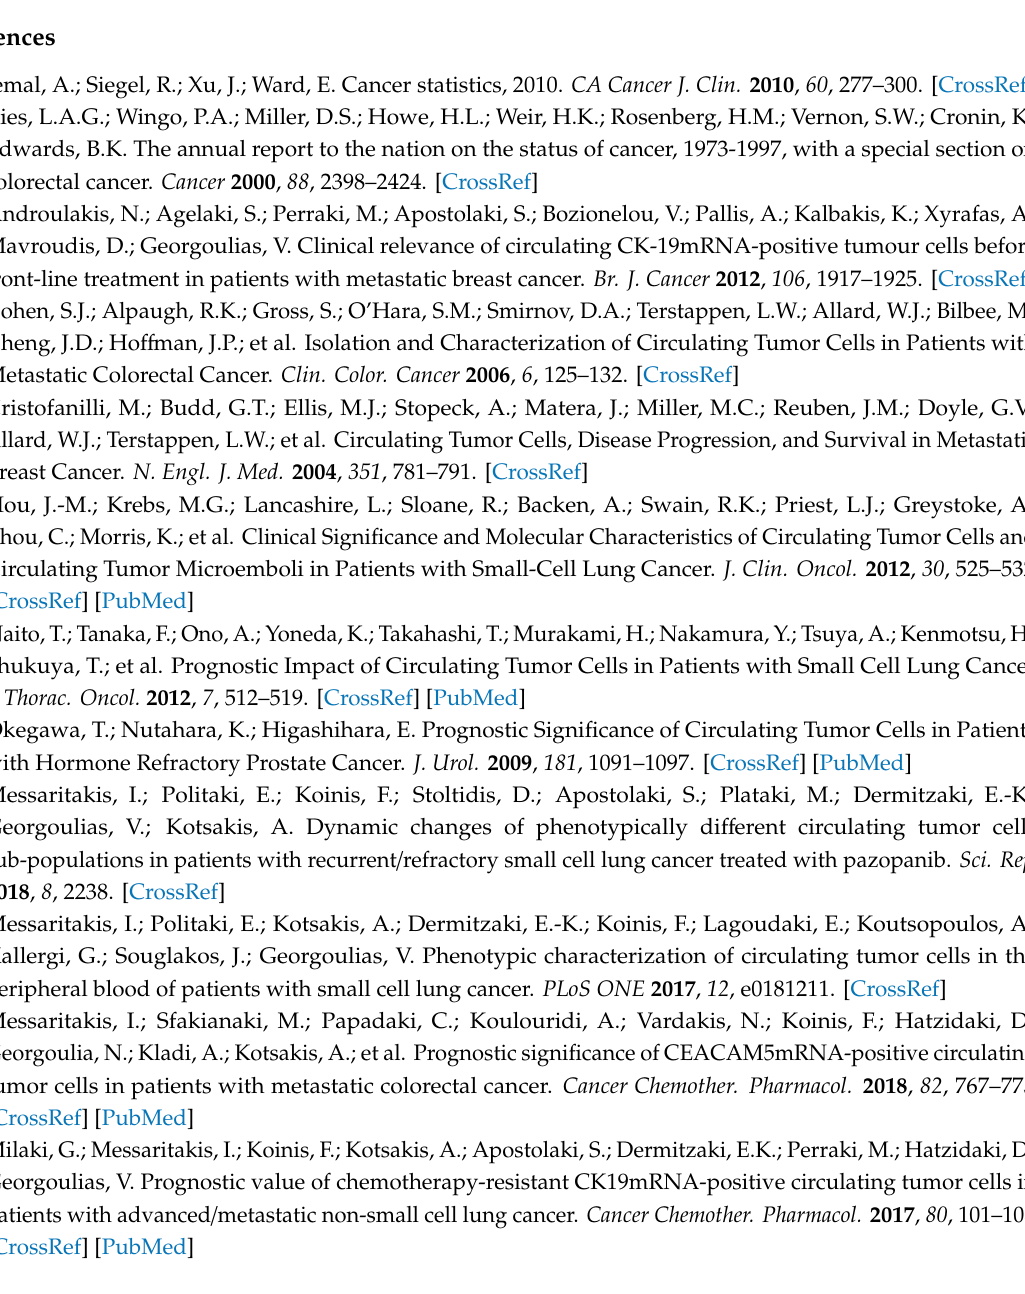
Table S1: Research